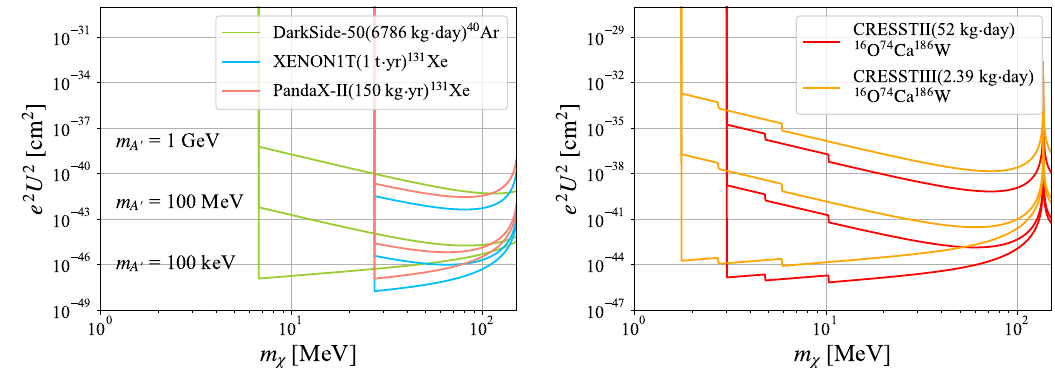
Figure 4 . The projected constraint on e 2 U 2 from dipole-charge contribution for both liquid (left) and crystal (right) targets, assuming different dark photon